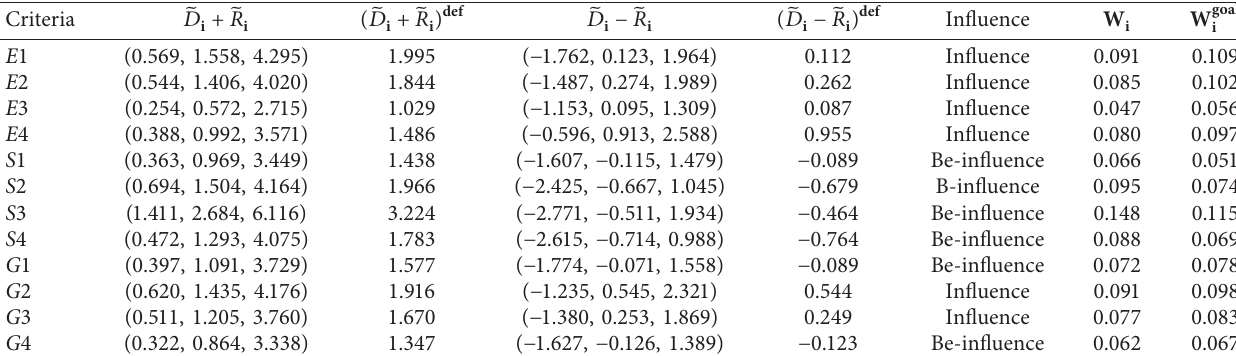
Table 41: Importance weight of sustainability criteria in fuzzy